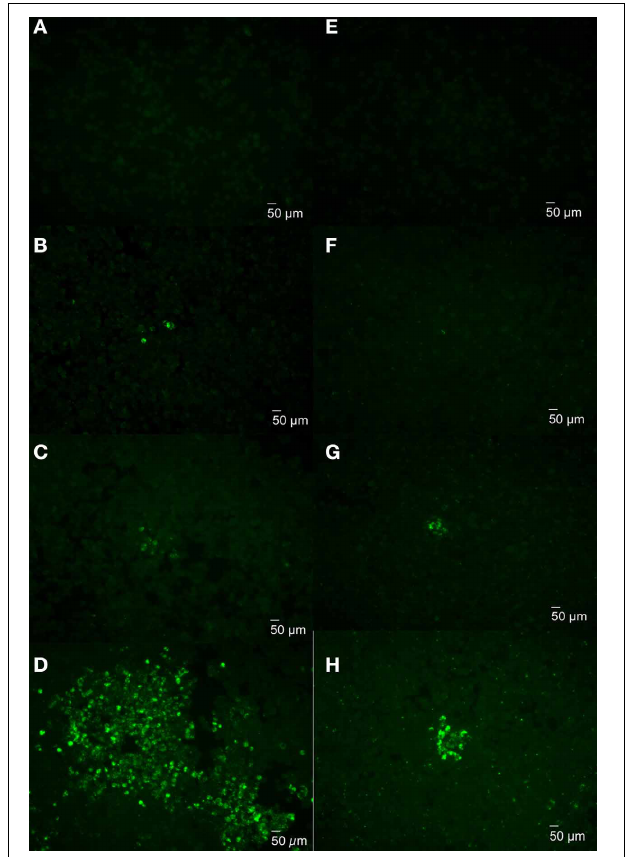
FIGURE 4 | Monitoring plaque formation during Brucella infection. J774.A1 macrophages were infected with 16M (cid:2) manBA (A–D) or 16M (cid:2) manBA (cid:2) virB 2 (E–H) at an MOI of 0.1. Agarose overlay and DMEM were added at 1h p.i. and incubated an additional 4 days. The cells were fixed at 1h (A,E) , 2 days (B,F) , 3 days (C,G) , and 4 days (D,H) p.i., and stained to visualize intracellular Brucella via IFA. Scale bar, 50 μ